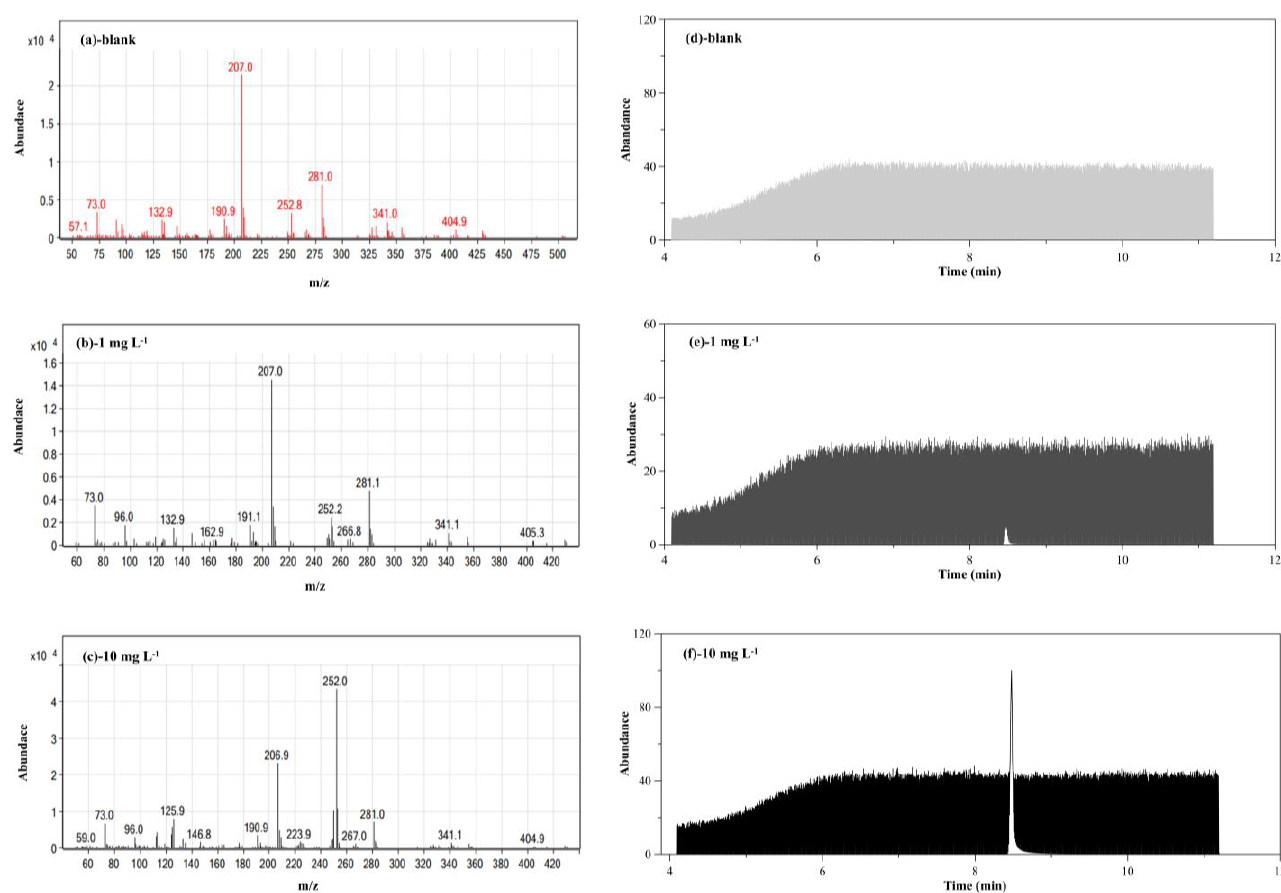
Figure 5. ( a – c ) Mass spectra, and ( d – f ) chromatograms of BaP at optimum conditions.